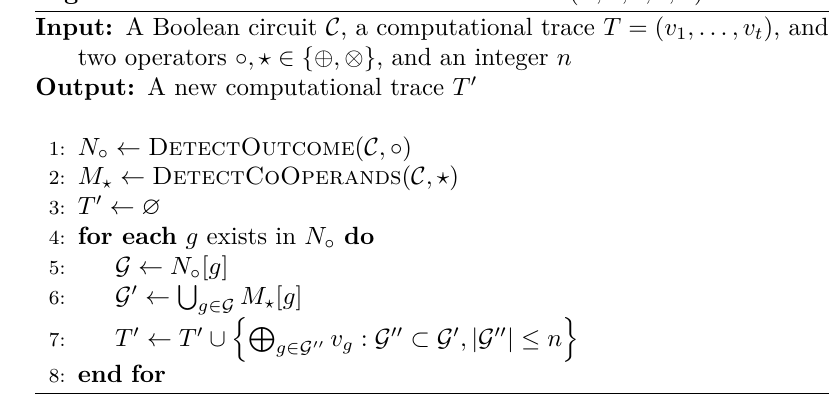
Algorithm 9 GeneralizedTraceProcessing ( T, C , ◦ , ?, n